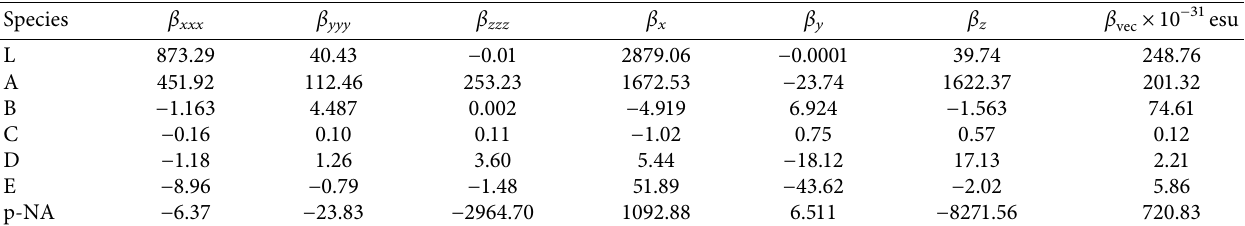
Table 12: Values of selected components of the frequency-dependent first hyperpolarizability, calculated at ω � 0.04282 a.u (1064nm) at the wB97xd/6-311++G level of theory.